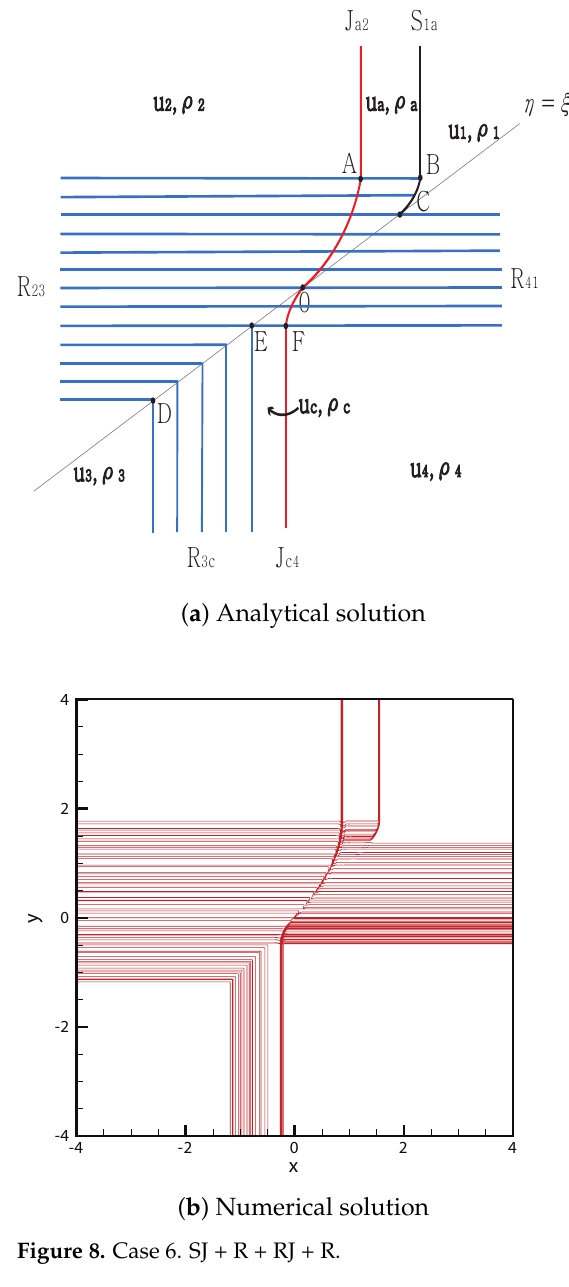
( b ) Numerical solution Figure 8. Case 6. SJ + R + RJ +